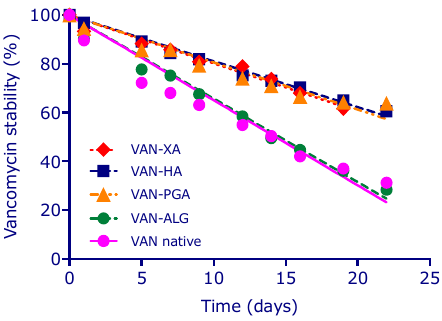
Figure 9. Residual concentration of native vancomycin within polysaccharidic hydrogels as a function of time.